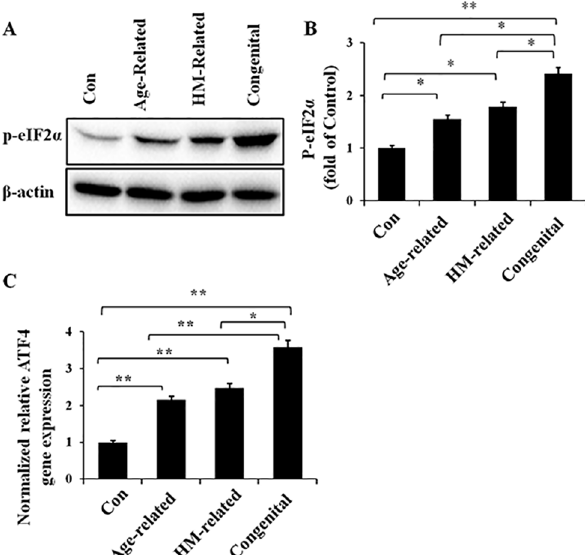
Fig 3. Up-regulated p-eIF2 α protein expression level and ATF4 gene expression level in the different cataract lens groups. RNA and protein were extracted from human lens specimens. Western blotting was performed to detect the protein expression of p-eIF2 α (Fig 3A and 3B), and β -actin was used as the internal control; real-time PCR was performed to detect the relative gene expression level of ATF4 in each group (Fig 3C), 18S rRNA was used as the internal control gene (mean ± SD, n = 3). * P < 0.05; ** P <